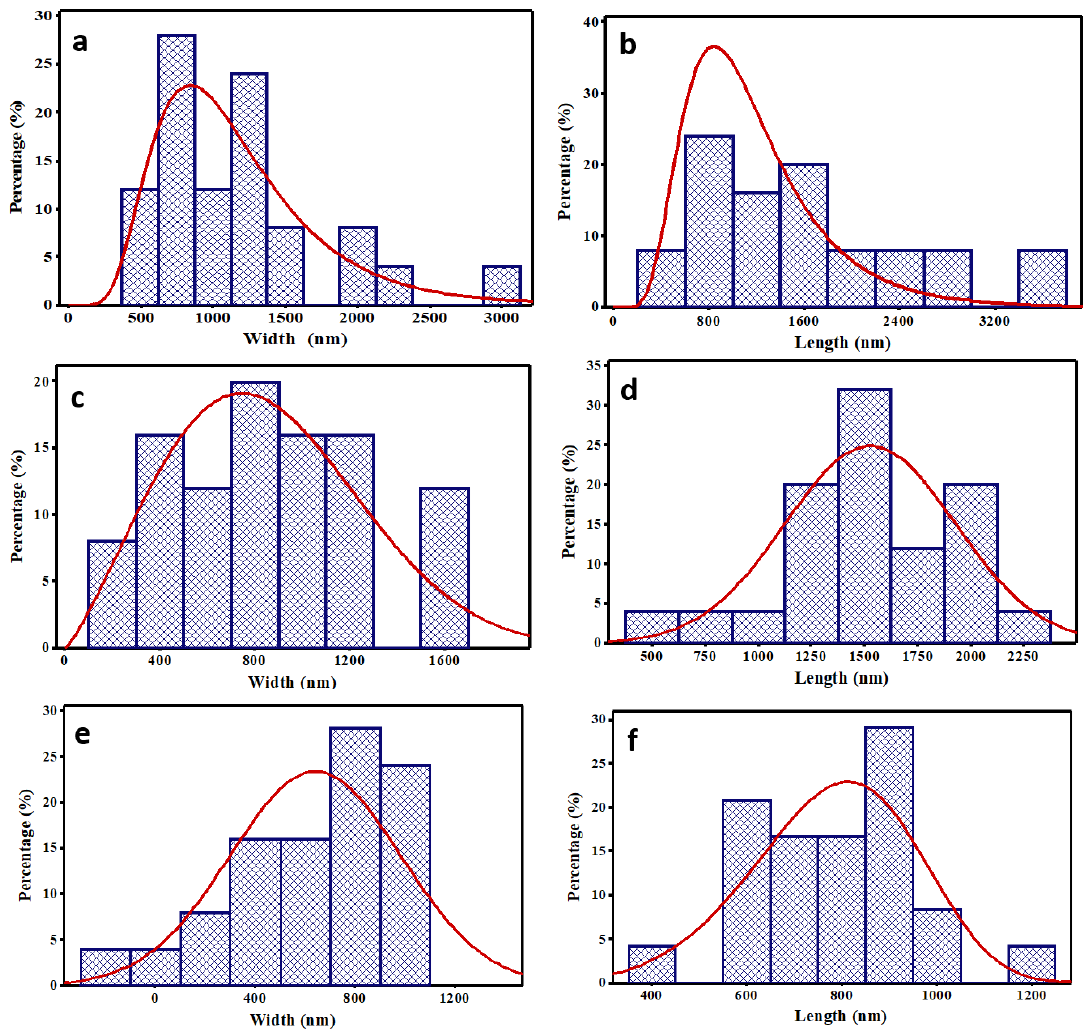
Figure 2. Dispersion plot of GOs’ lateral dimensions. ( a ) GO1 width; ( b ) GO1 length; ( c ) GO2 width; ( d ) GO2 length; ( e ) GO3 width; ( f ) GO3 length. Table 1. Percentages of population size distribution for used GOs.